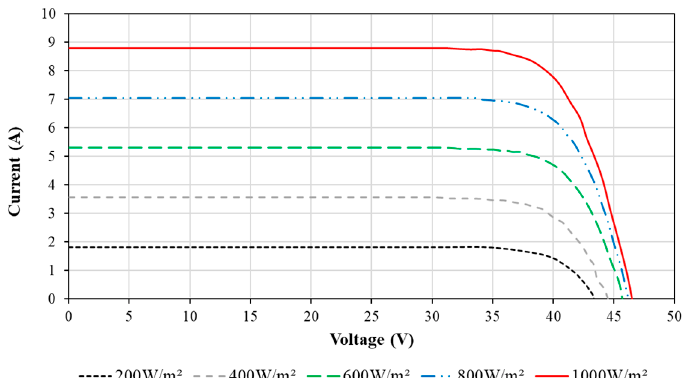
Figure 4. I-V curves for the selected module under various solar irradiation levels.